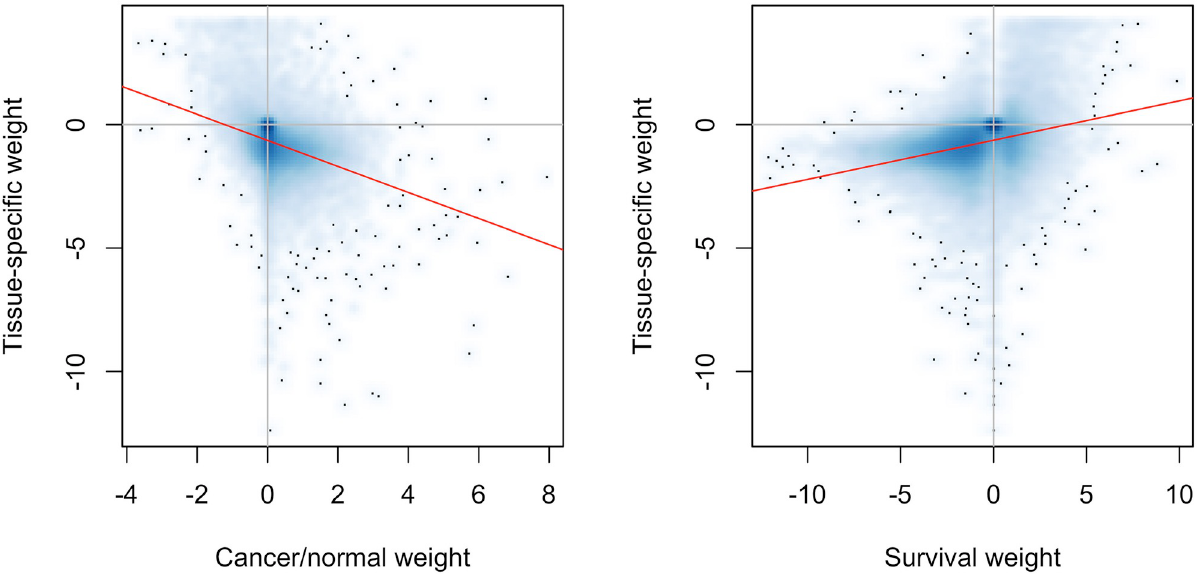
Fig 3. Association of liver-specificity ( n � ), liver cancer/normal liver differential expression ( r i ,LIHC ) and liver cancer prognostic value ( s i ,LIHC ). i ; liver Each point in both plots represents a single gene and the red lines reflect the linear regression fit. a) Association between liver-specificity and differential expression between liver cancer and normal liver. b) Association between liver-specificity and prognostic value of gene expression for liver cancer.